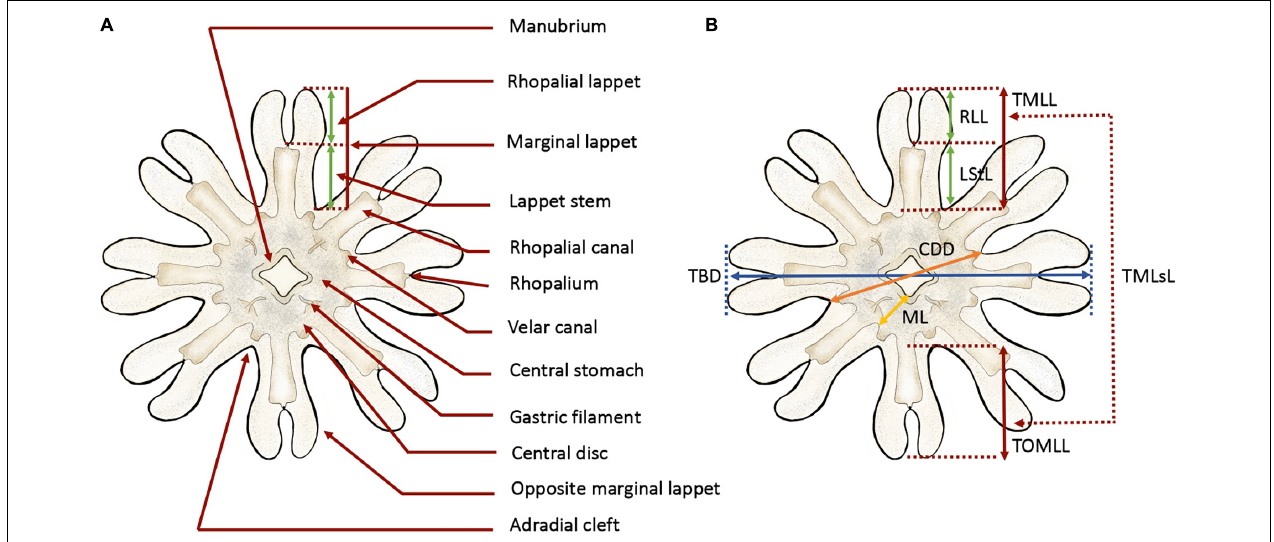
FIGURE 1 | Anatomy and measuring points defined for ephyra and metaephyra stages. (A) Anatomy of ephyra. (B) Measuring points. CDD , central disk diameter; LStL , lappet stem length; ML , manubrium length ; RLL , rhopalial lappet length; TBD , total body diameter; TMLL , total marginal lappet length; TMLsL, total marginal lappets length; TOMLL , total opposite marginal lappet length. Illustrated by Lau